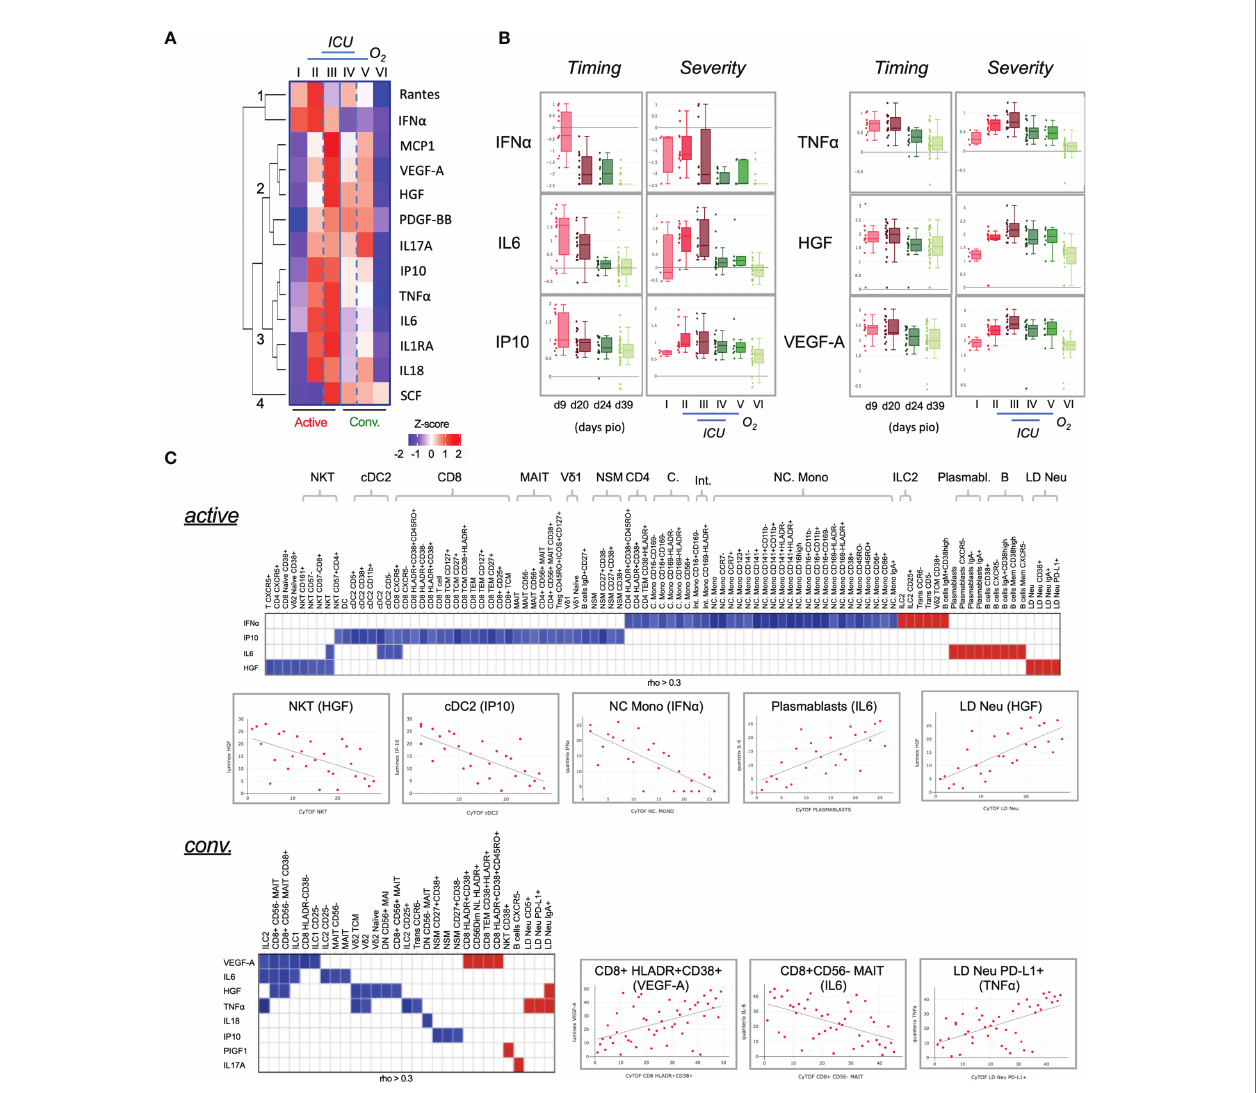
FIGURE 6 | Characterization of cytokines in COVID-19 patients. (A) Changes in cytokine levels among COVID-19 patients based on timing and severity. The heatmap shows the z-scores of the mean logarithmically transformed concentration of the 13 cytokines (of a total of 28) showing signi fi cant differences between any of the 6 severity groups. The z-scores are colored in red for positive values and in blue for negative values. The cytokines are clustered using hierarchical clustering using Euclidean distances into four clusters, which are labeled 1 to 4 in the fi gure. (B) Box plots of selected cytokines showing differences in timing and/or severity. The timing (left panels) refers to the plasma cytokine levels detected on the respective day post illness onset (PIO), the severity (right panels) to the levels detected in the 6 severity groups. Red colors refer to samples from the active phase, green to convalescence phase. An interactive viewer is available in the online content: data availability section. (C) Associations between cytokine level and cell frequency during active and convalescent phase. The heatmap displays the strength of the association indicated by the correlation coef fi cient (rho). Color indicated the direction (Red: positive, blue: negative). Only associations abs(rho) > 0.3 and p < 0.05 are shown. Selected examples of these correlations are shown in the scatter plots. An interactive viewer is available in the Materials and Methods: Data and Code Availability